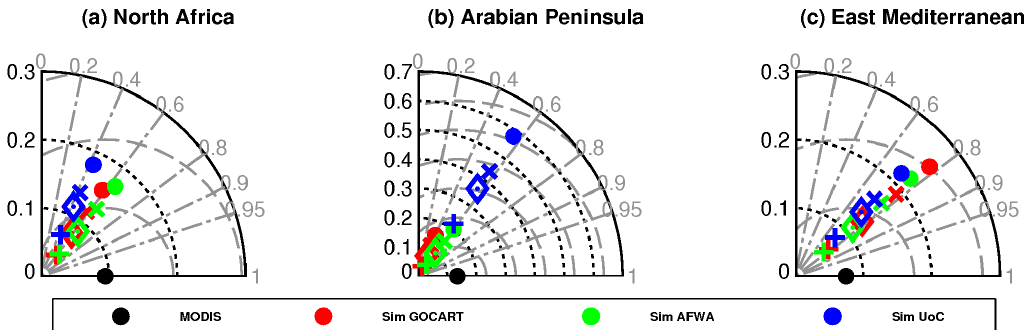
Figure 7. Taylor diagram comparing time series of AOD for all simulations to the MODIS observations as shown in Fig. 6. Root mean square error lines are plotted with a 0.1 interval. Symbol annotations are the same as in Fig.